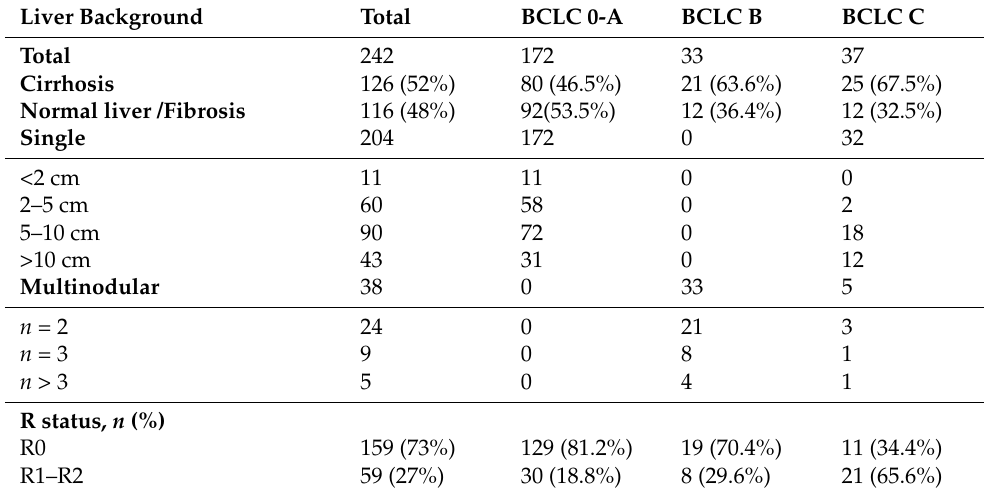
Table 3. Histopathology